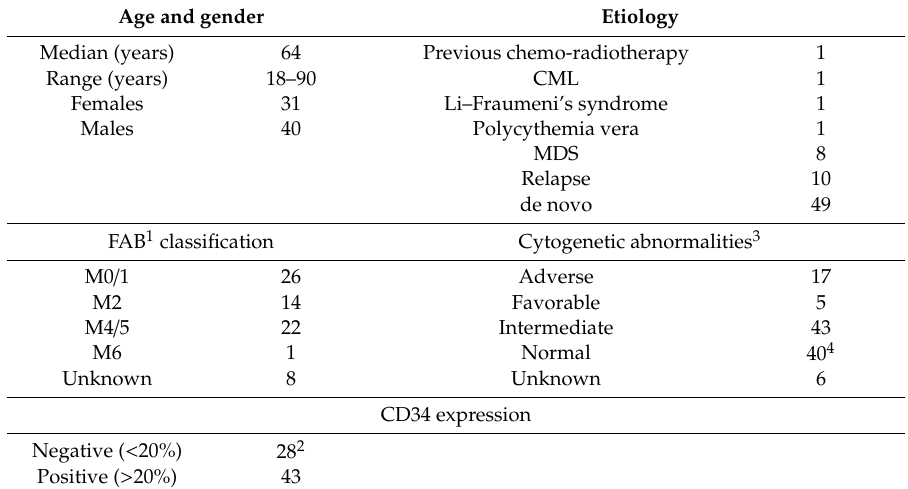
Table 1. The clinical and biological characteristics of the 71 acute myeloid leukemia (AML) patients included in the